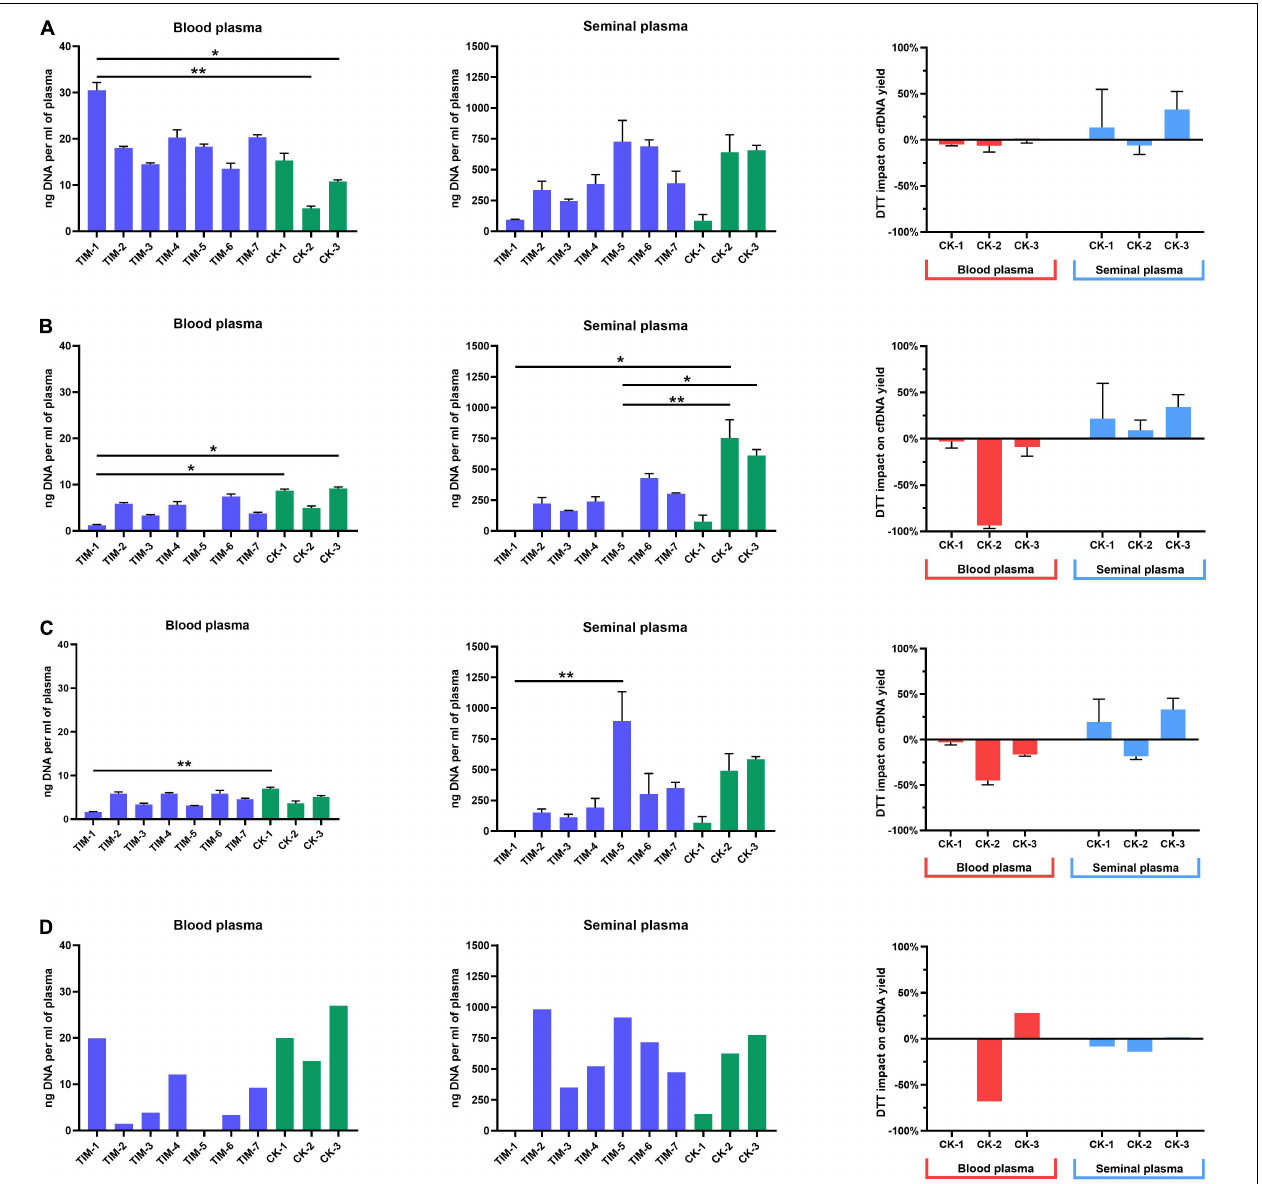
FIGURE 4 | Cell-free DNA yields from blood and seminal plasma. (A) Yields measured by fluorometry, with DTT impact on commercial kits depicted as percentage change; (B) yields measured by qPCR analysis of LINE-1, with DTT impact on commercial kits depicted as percentage change; (C) yields measured by ddPCR, with DTT impact on commercial kits depicted as percentage change; (D) yields measured by capillary electrophoresis, with DTT impact on commercial kits depicted as percentage of change. Values represented are means with SD. Asterisks were used to depict statistical significance, * P < 0.05, ** P <